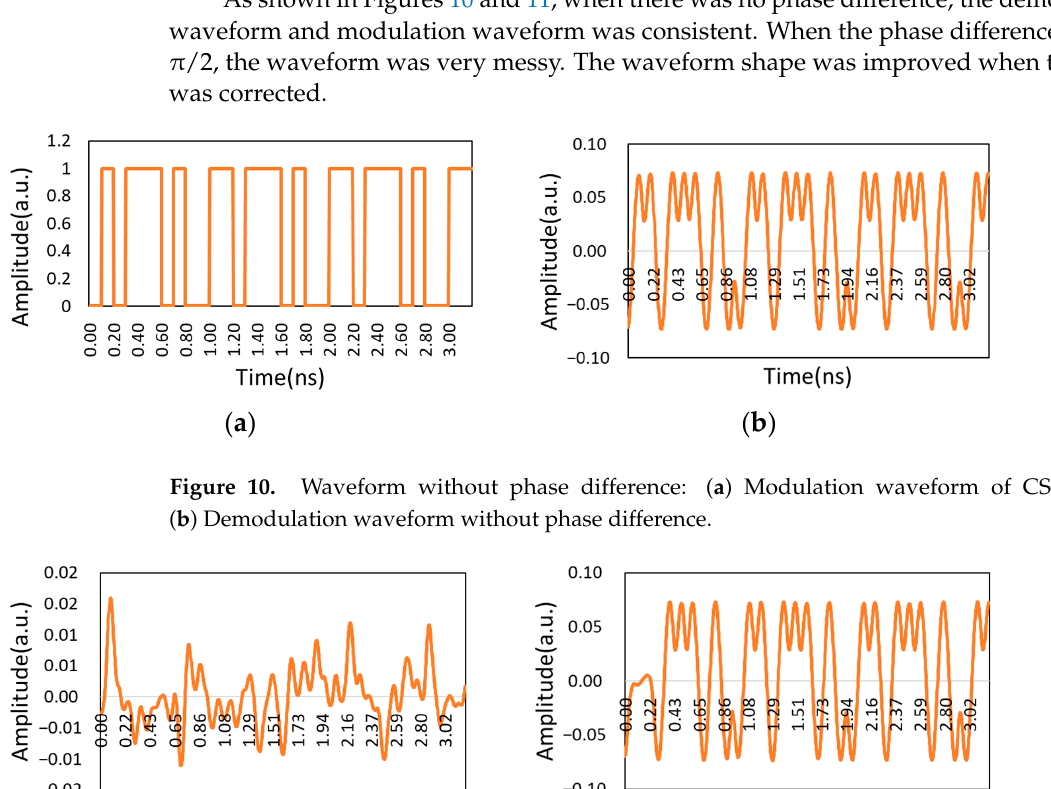
Figure 10. Waveform without phase difference: ( a ) Modulation waveform of CSRZ-DPSK; ( b ) De- modulation waveform without phase difference.